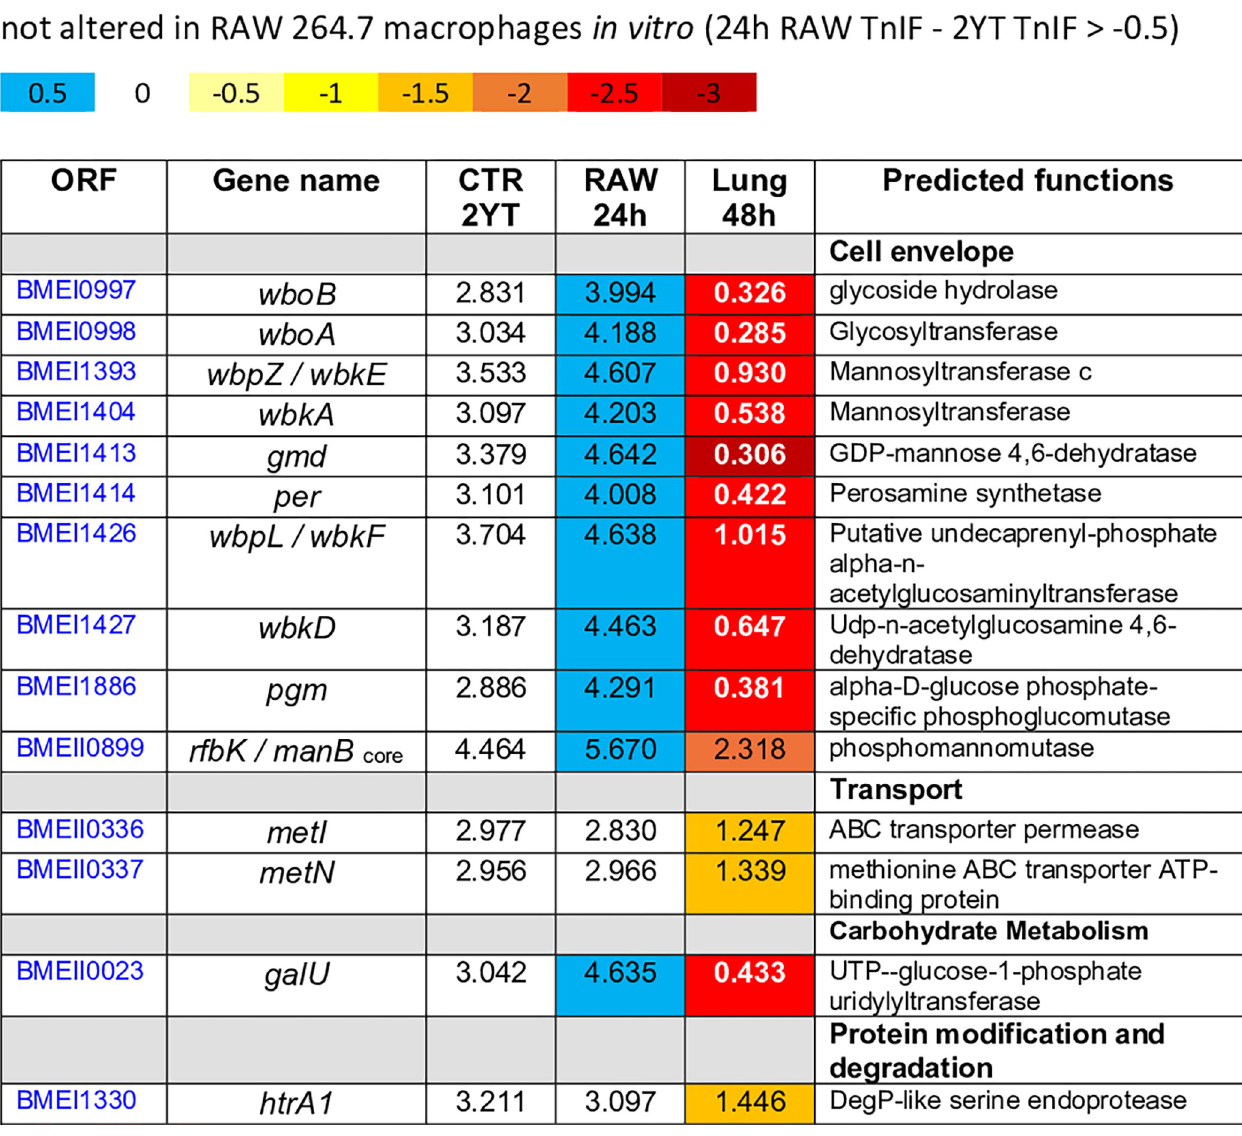
Fig 7. List of 14 Very Low Fitness (VLF) genes specific to the lung condition ( Δ TnIF lung 48 hours < -1.5, Δ TnIF RAW 264.7 > -0.5) with TnIF values in the 2YT, RAW 264.7 and lung conditions, as well as a predicted function. Color scale shows the score of Δ TnIF of each gene.